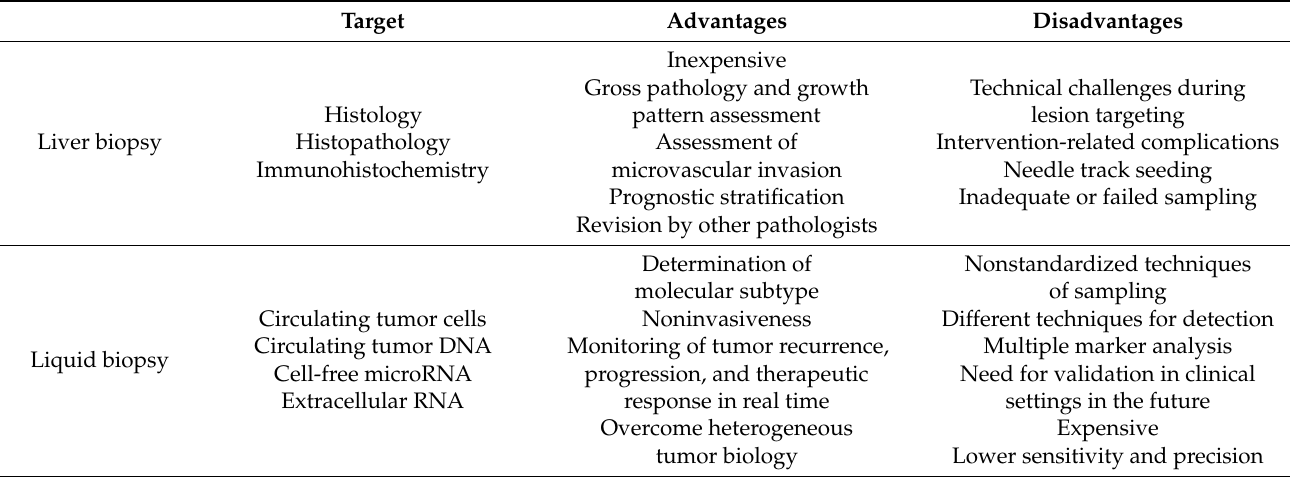
Table 1. Comparison between liver biopsy and liquid